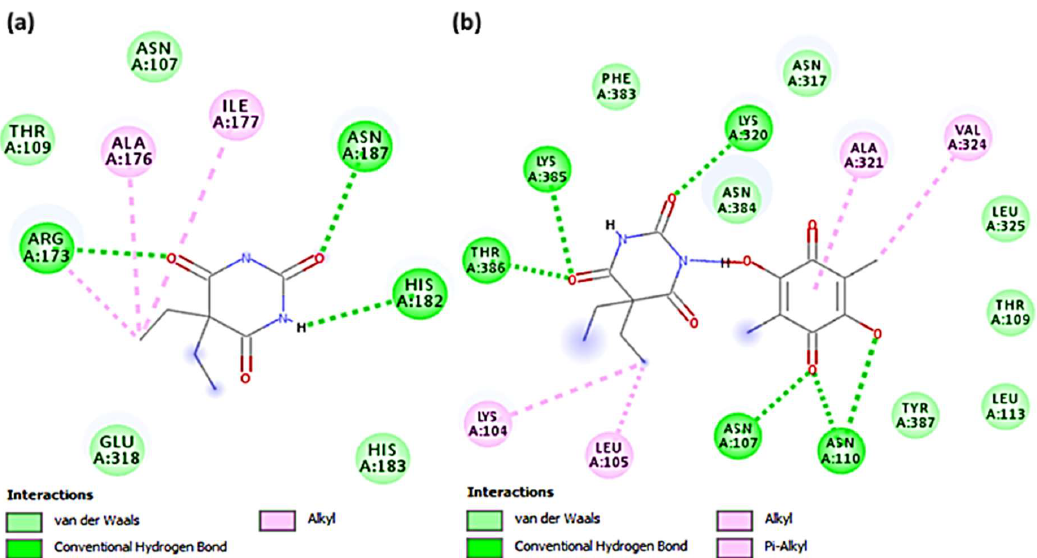
Figure 5. Two-dimensional illustrations of a serotonin receptor docked with ( a ) (Bar–CLA) complex and ( b ) Bar alone.